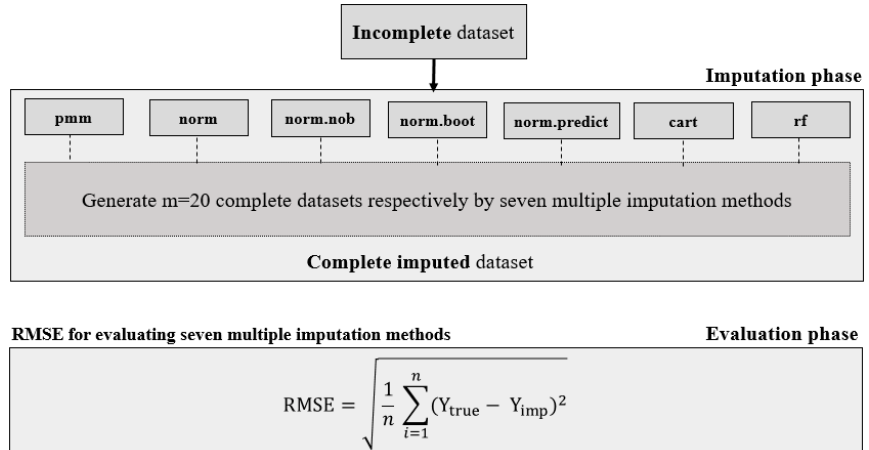
Figure 2. Multiple imputation comparison of seven different methods. Abbreviations: RMSE, root mean square error; pmm, predictive mean matching; norm, Bayesian linear regression; norm.nob, linear regression ignoring model error; norm.boot, linear regression using bootstrap; norm.predict, linear regression, predicted values; cart, classification and regression trees; rf, random forest imputations [36].